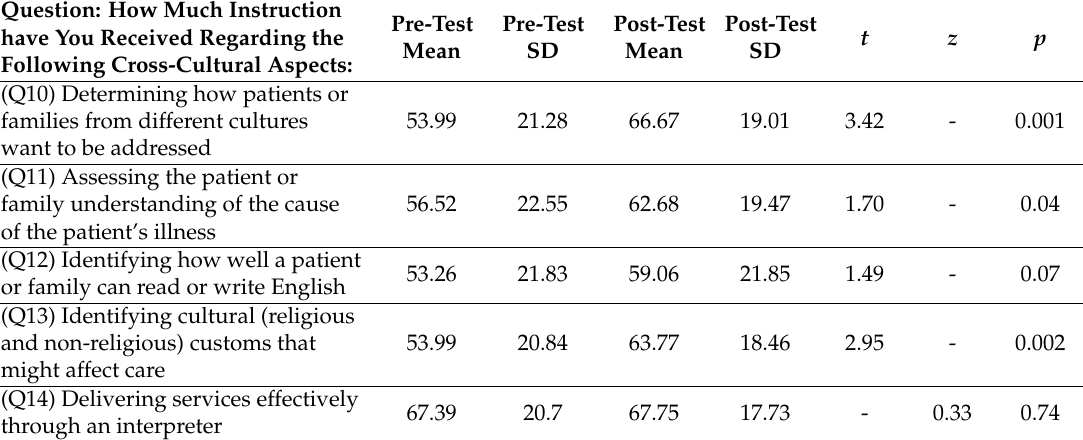
Table 3. Training and experience a,b .